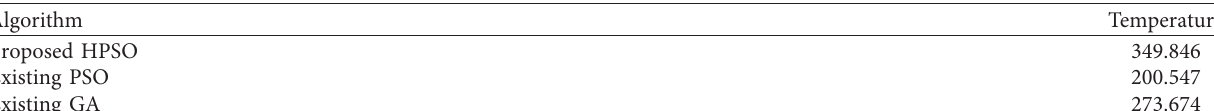
Table 3: The performance of the proposed HPSO with the existing PSO and GA based on optimal temperature.